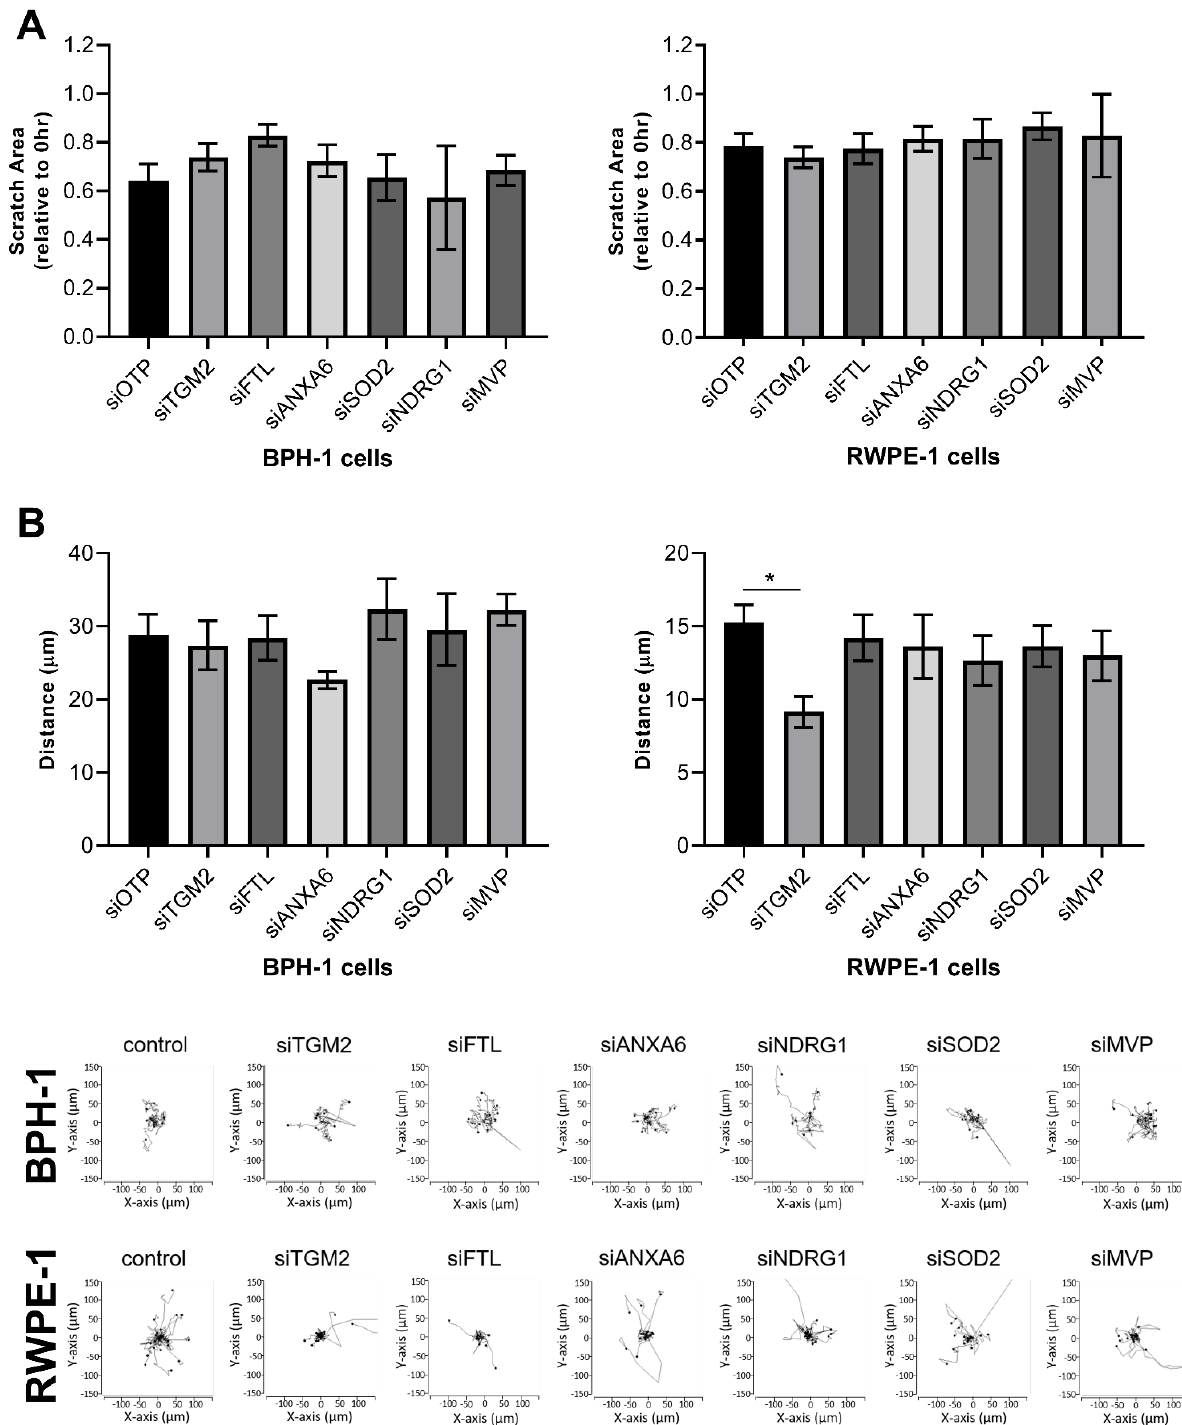
Figure 8. Functional interrogation of selected candidates via migration assays. ( A ) Scratch closure assay of BPH-1 and RWPE-1 benign prostate epithelial cells. Data represent scratch area 16 h post- scratch relative to 0 h timepoint. Mean ± SEM, n = 3. ( B ) Random cell migration assay of prostate epithelial cells in co-culture with CAFs. GFP-positive BPH-1 and RWPE-1 cells were cultured with GFP-negative CAF cells over 16 h. GFP-positive cells were tracked for total distance travelled. Mean ± SEM, n = 4. One-way ANOVA. * p < 0.05. Representative plots of x - and y -axis movements for BPH-1 and RWPE-1 cells in co-culture with CAFs are shown underneath.